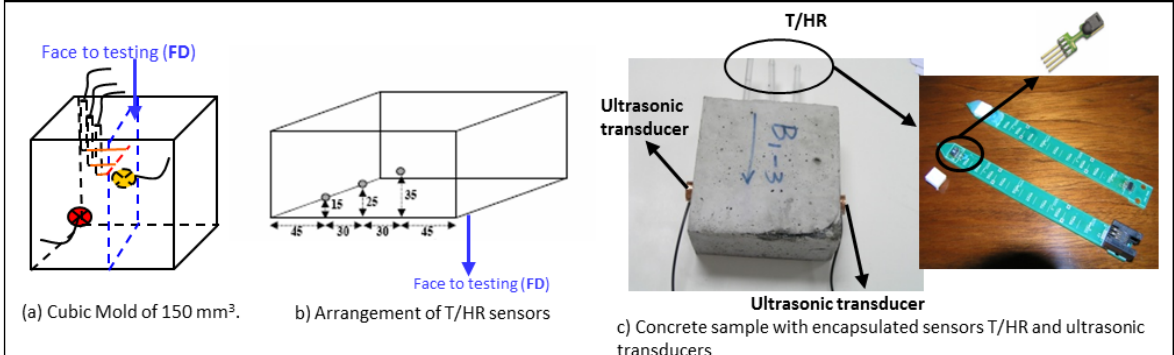
Figure 5. Arrangement of T/RH and US sensors in concrete specimens.